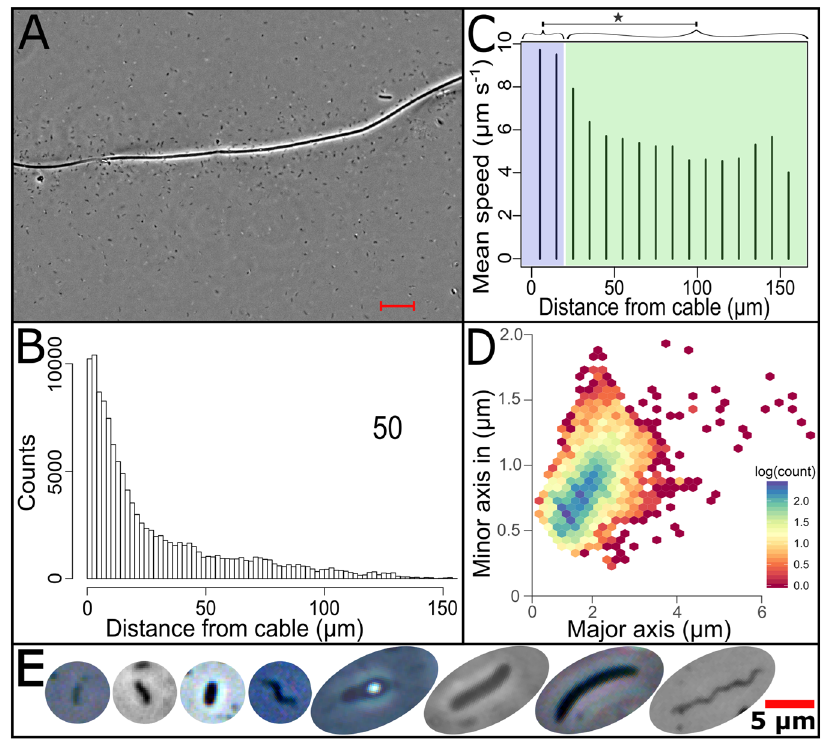
Fig. 1 | Documentation and main properties of bacterial fl ocks around cable bacteria.A Flockingbacteriaattractedtoacablebacterium fi lament(center)(Scale bar, 10 µ m). B Counts of swimming bacteria at different distances to the cable bacterium fi lament (960,071 counts of 3211 fl ocking bacteria in 12 video frames, mean distance 17.42 µ m. The means of the individual samples ranged from 4.96 to 24.58 µ m. C Difference in mean swimming speed of bacterial cells relative to their distance to the cable bacterium fi lament. The shaded blue area corresponds to a